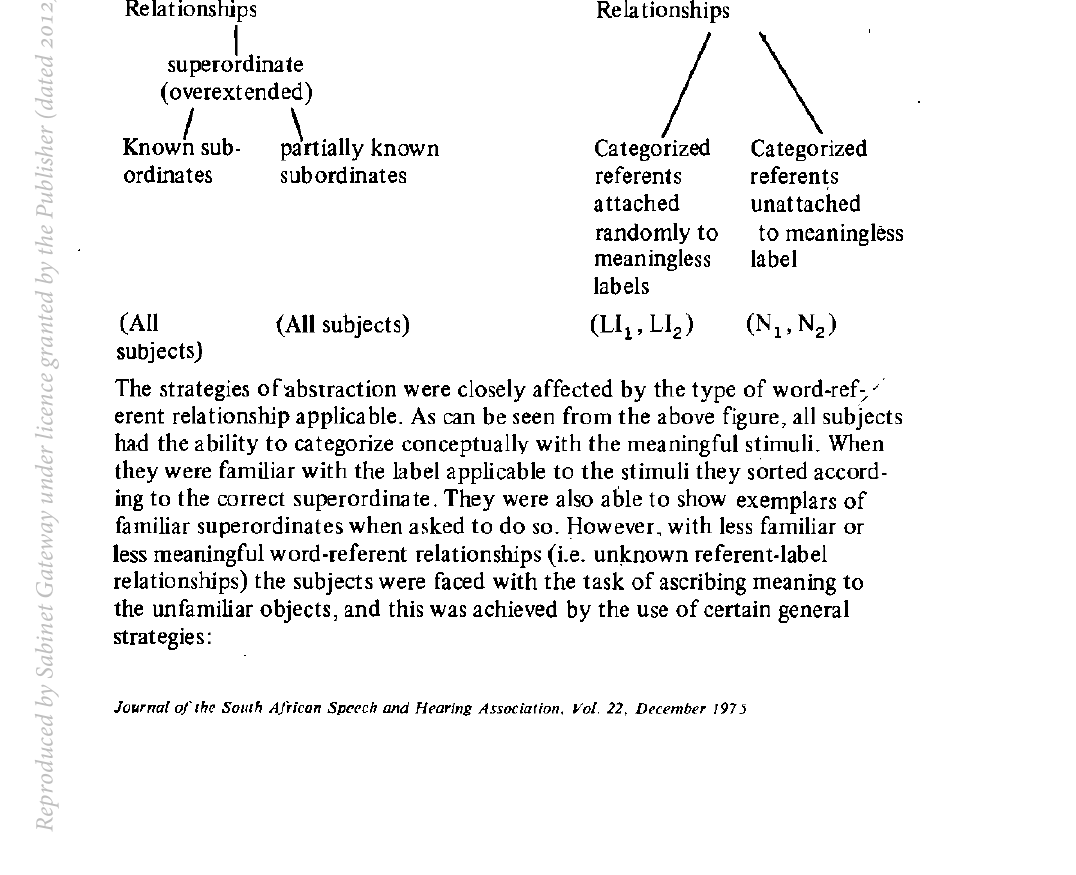
Word-Referent Relationships found in the